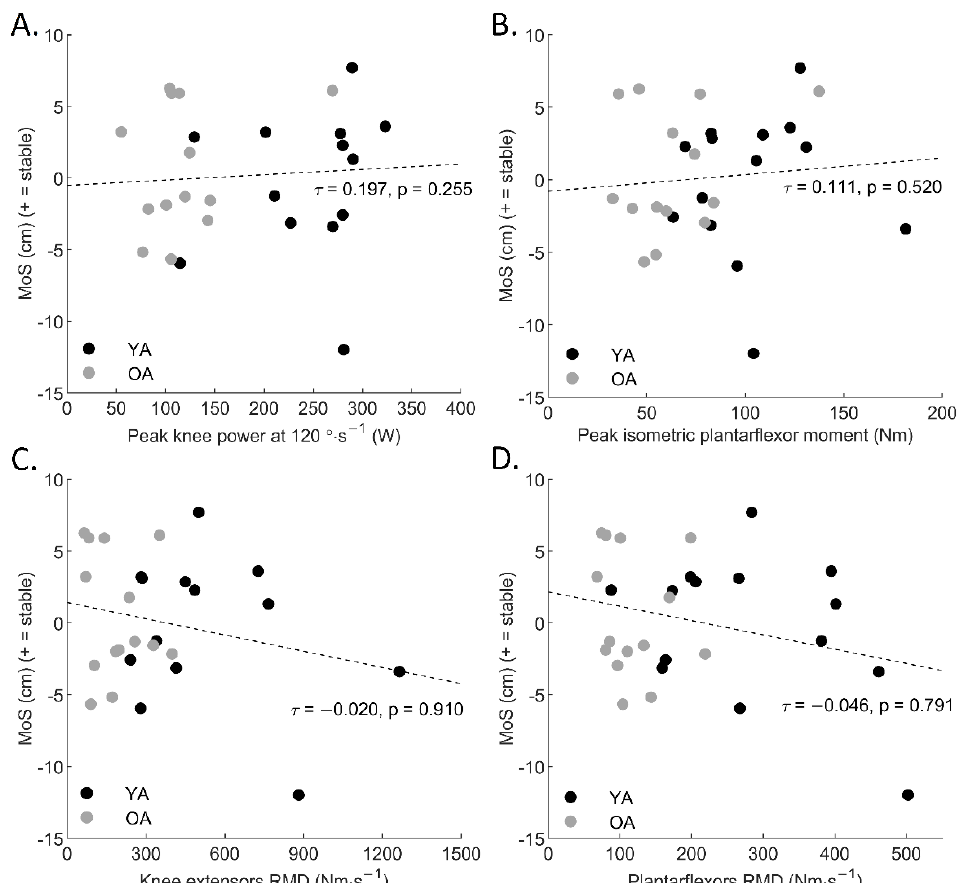
Figure 2. Correlations between ( A ) peak knee power at 120 ◦ · s − 1 and margin of stability ( p > 0.05), ( B ) peak plantarflexor moment and margin of stability ( p > 0.05), ( C ) knee extensors rate of moment development and margin of stability ( p > 0.05), ( D ) plantarflexors rate of moment development and margin of stability ( p > 0.05). YA: young adults, OA: older adults.